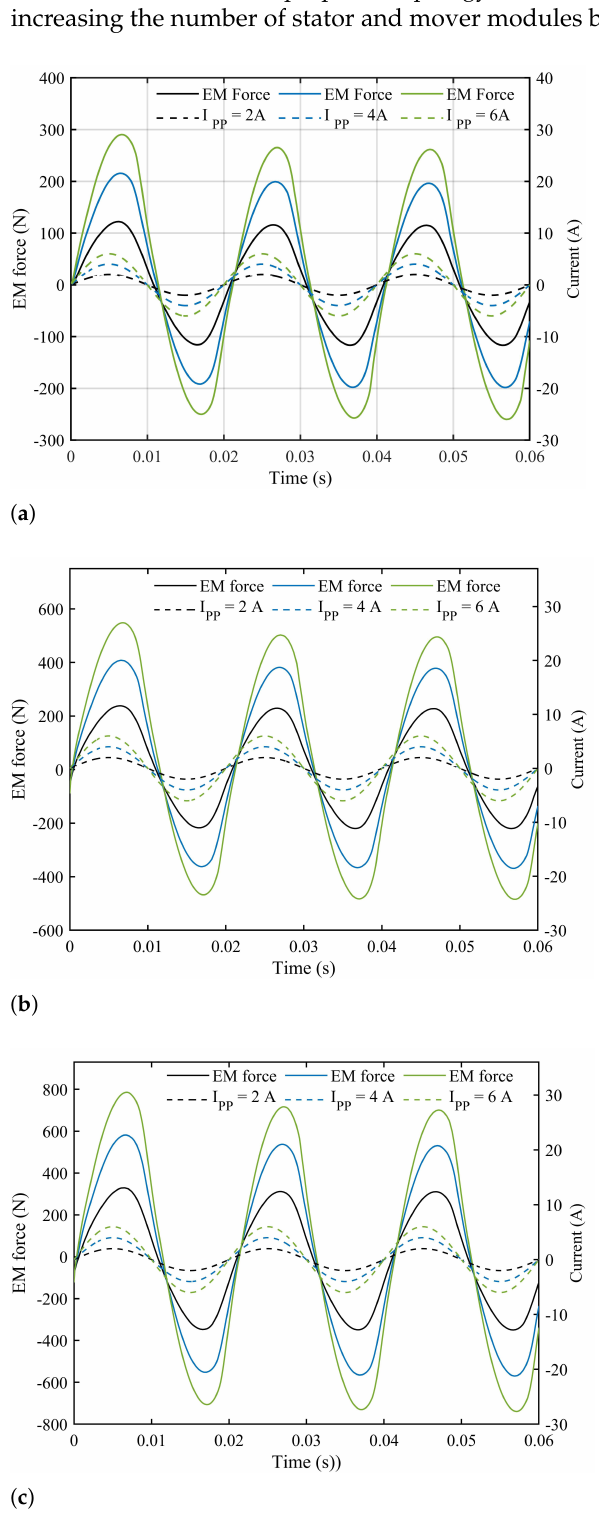
Figure 13. Thrust force of proposed TMM-LOA under transient conditions: ( a ) one module; ( b ) two modules; and ( c ) three